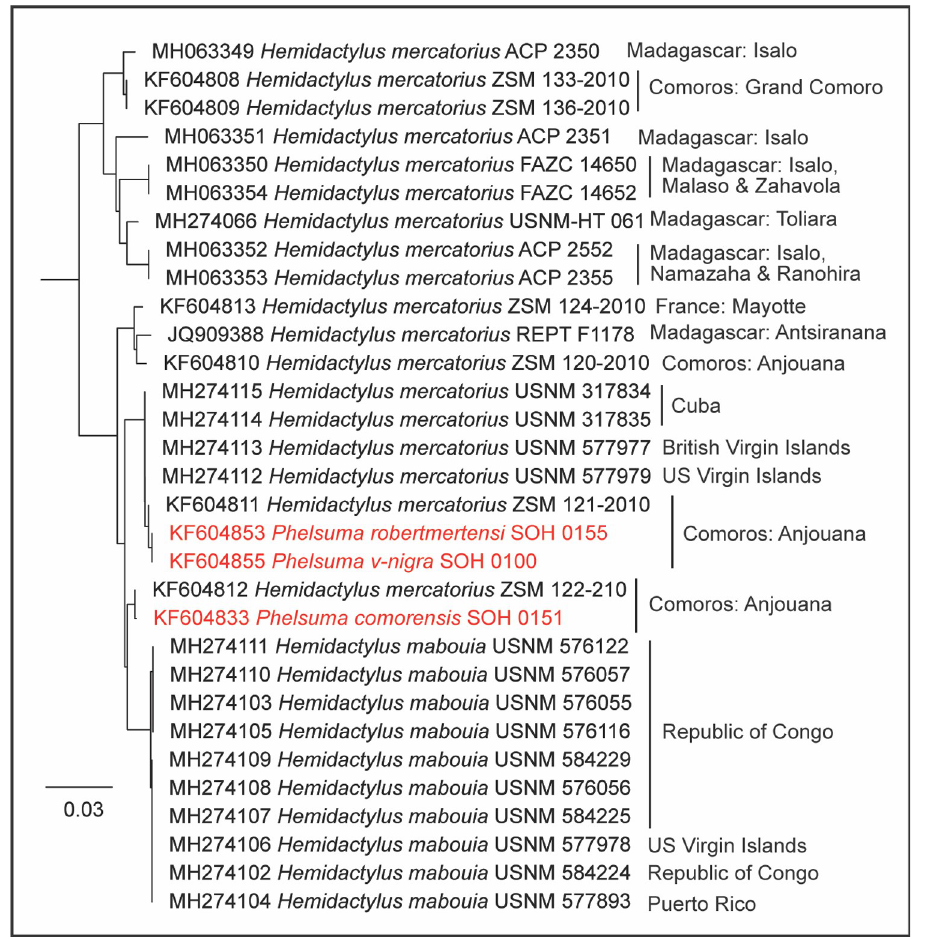
Fig 2. NJ tree of Hemidactylus mabouia and H . mercatorius COI sequences in GenBank. Sequences are shown by GenBank Accession number, followed by the species, and specimen number. Localities are shown to the right. Red sequences are mis-labelled specimens in GenBank and BOLD (see text). The localities given for the mis-labelled specimens are those of the H . mercatorius samples to which they correspond, inferred from the published tree [39]. GenBank Accession numbers beginning with MH274 are from this study, those beginning with KF604 are from Hawlitschek et al.